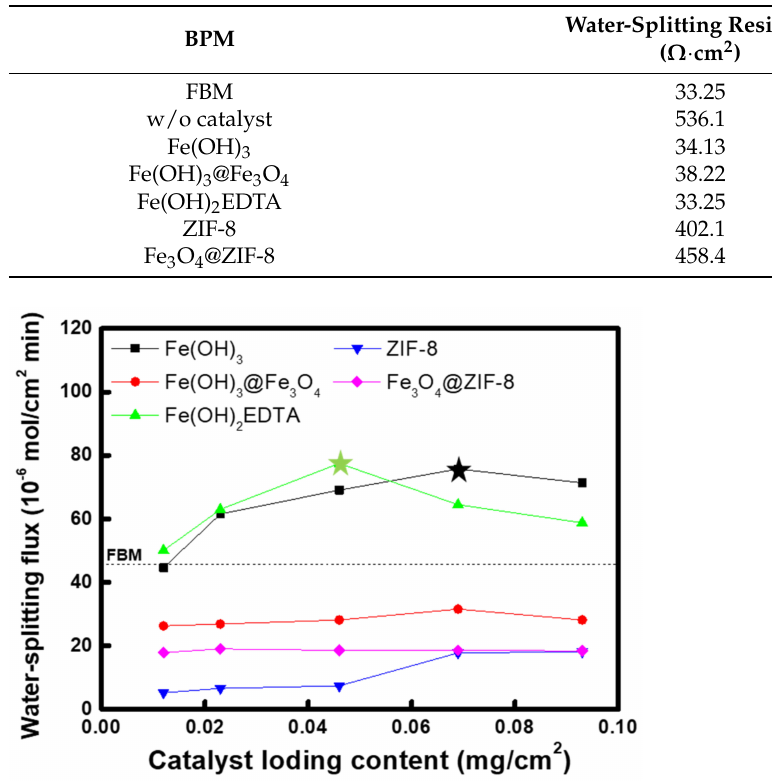
Figure 11. Variation of water-splitting flux of BPMs according to catalyst loading